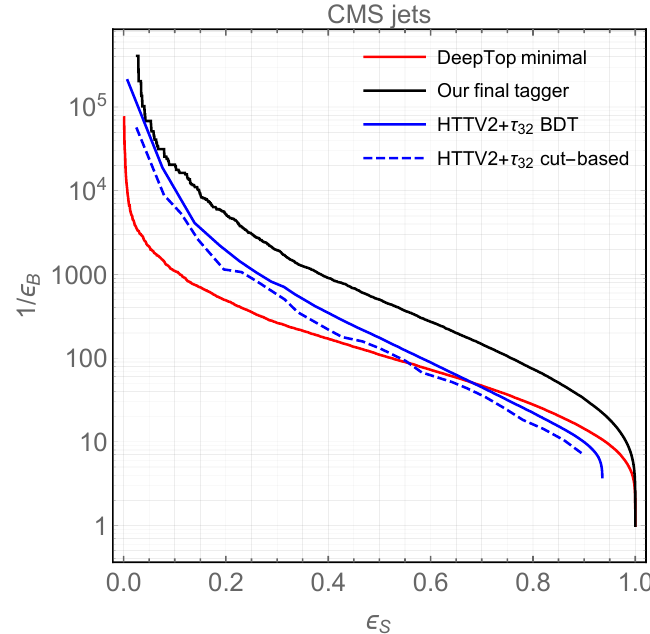
Figure 8 . ROC curves comparing our best top tagger (black), the original DeepTop tagger (red), the cut-based top-tagger from [42] using variables from HTTV2 and (cid:28) 32 (blue dashed), and a BDT built out of those same variables (blue solid), for the CMS jet